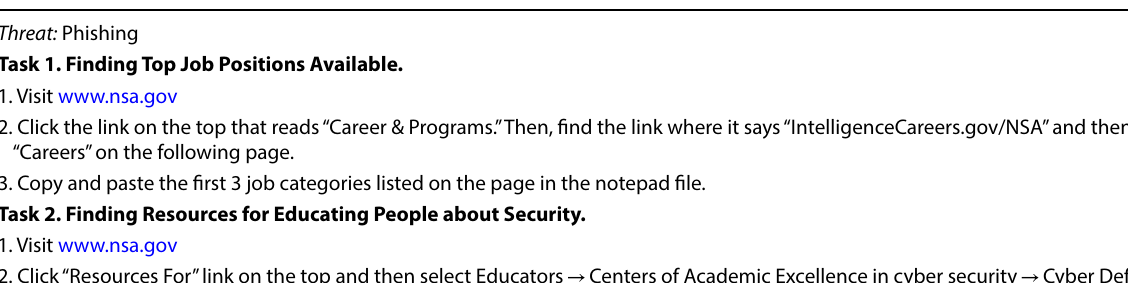
Table 2 The scenarios used in the study (Part 1) Threat, Scenarios, and Tasks Threat: